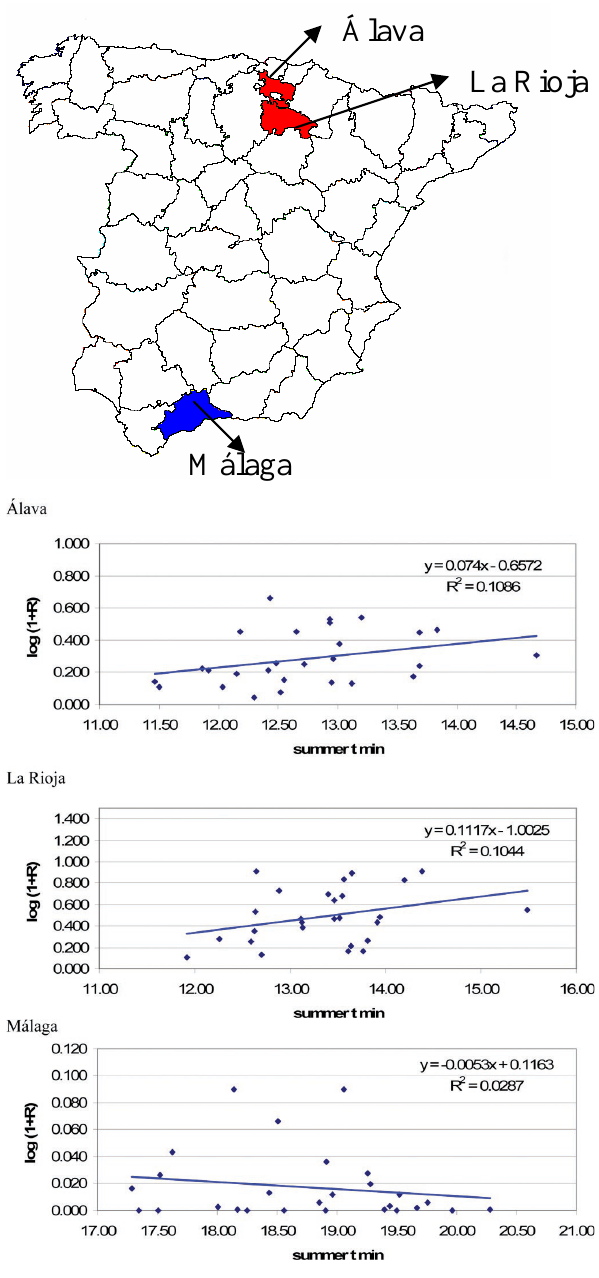
Fig. 5. Significant correlations according to Kendall’s tau test be- tween hail damage and minimum summer temperature, excluding those provinces that gave a Pearson r significant. Graphs show minimum summer temperature at the x-axis (summer t min) and transformed hail damage index (log(1+ R )) at the